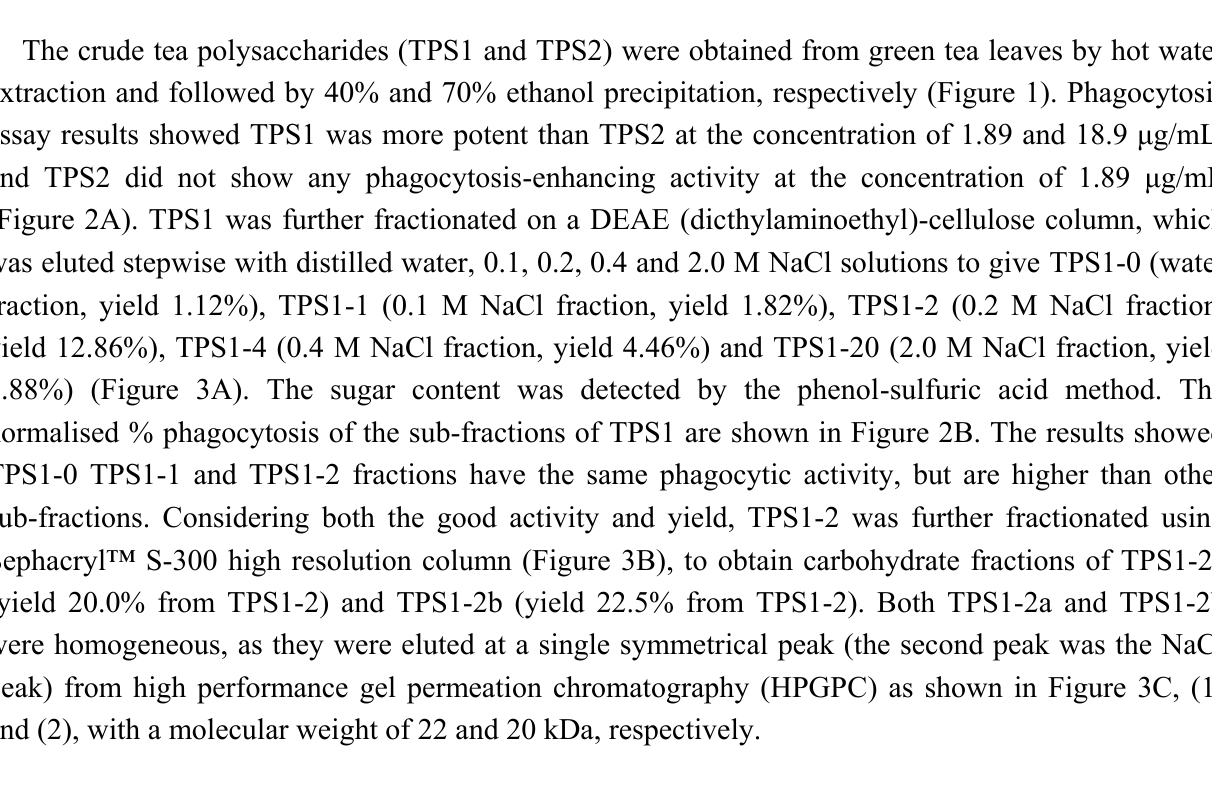
Figure 1. Flow chart of the isolation of aqueous polysaccharides from green